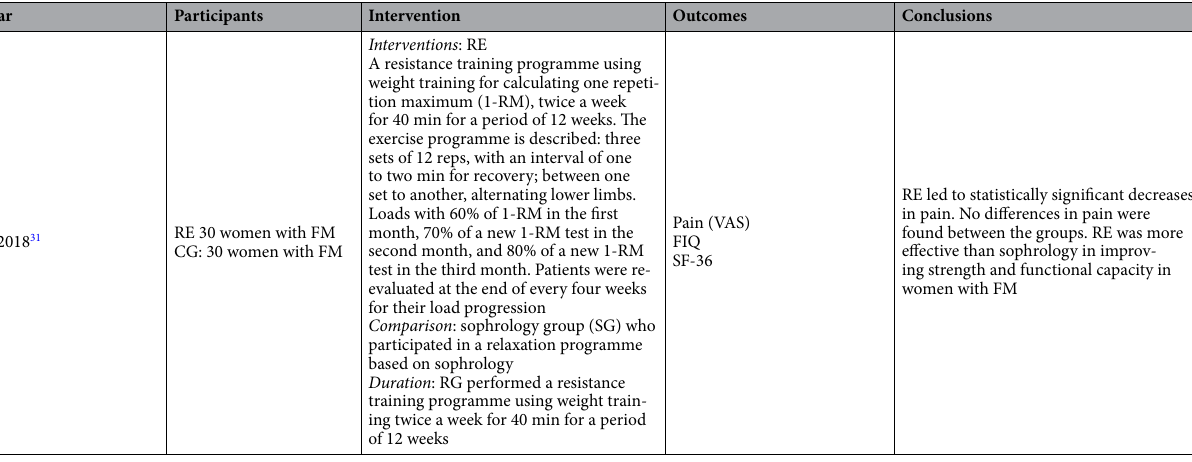
Table 4. Characteristics of the included